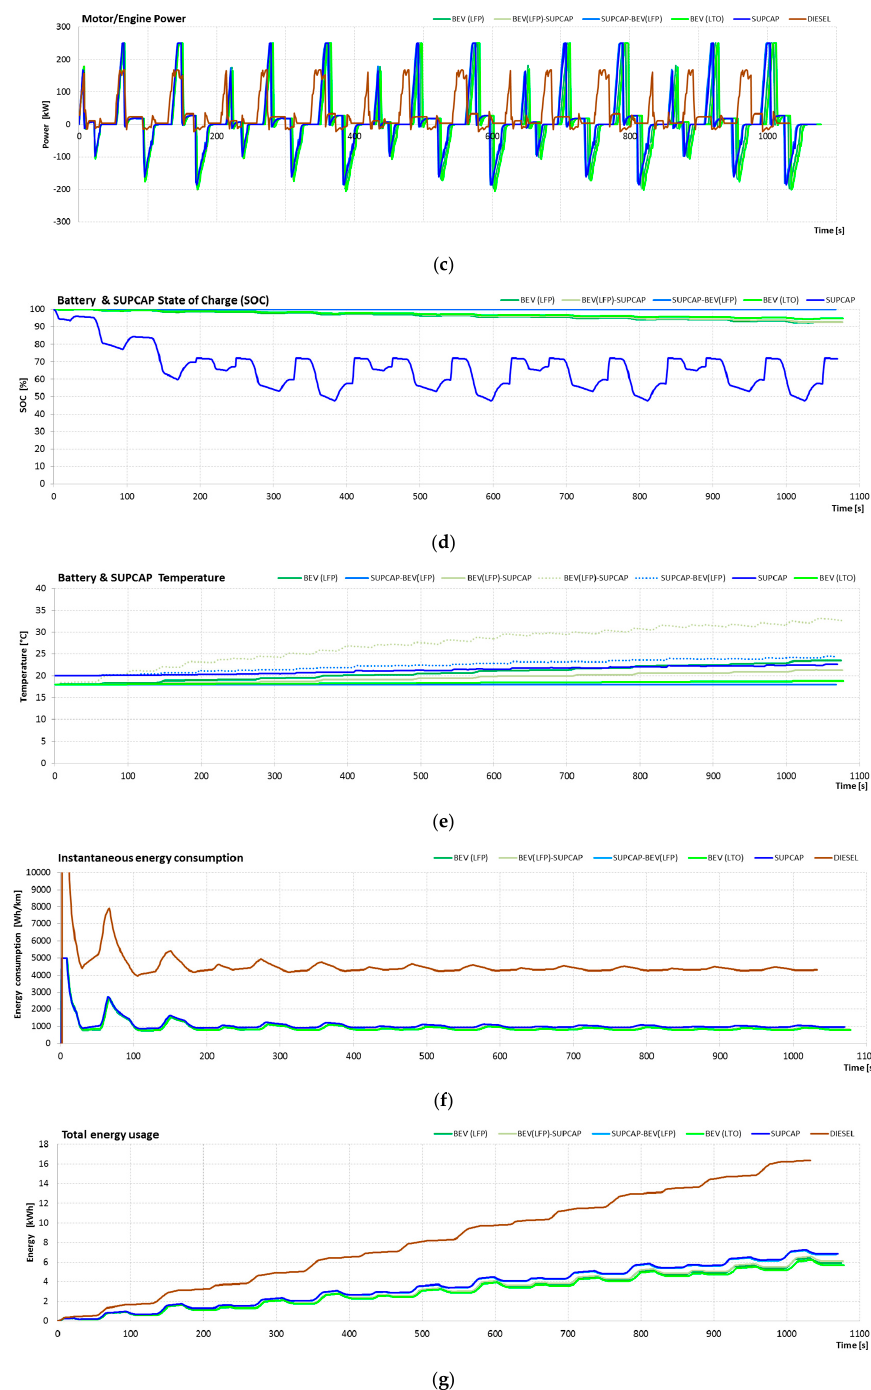
Figure 13. SORT 3 results of simulation tests, where: ( a ) Bus speed during tests (km/h); ( b ) Voltage and Current on DC-link (V), (A); ( c ) Motor/Engine Power (kW); ( d ) Battery & SUPCAP State of Charge (%); ( e ) Battery & SUPCAP temperature (°C); ( f ) Instantaneous energy consumption (Wh/km); ( g ) Total energy usage (kWh).